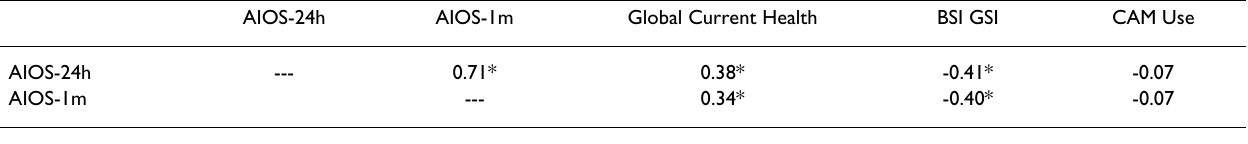
Table 4: Correlations between AIOS and Other Measures in University Students (N =